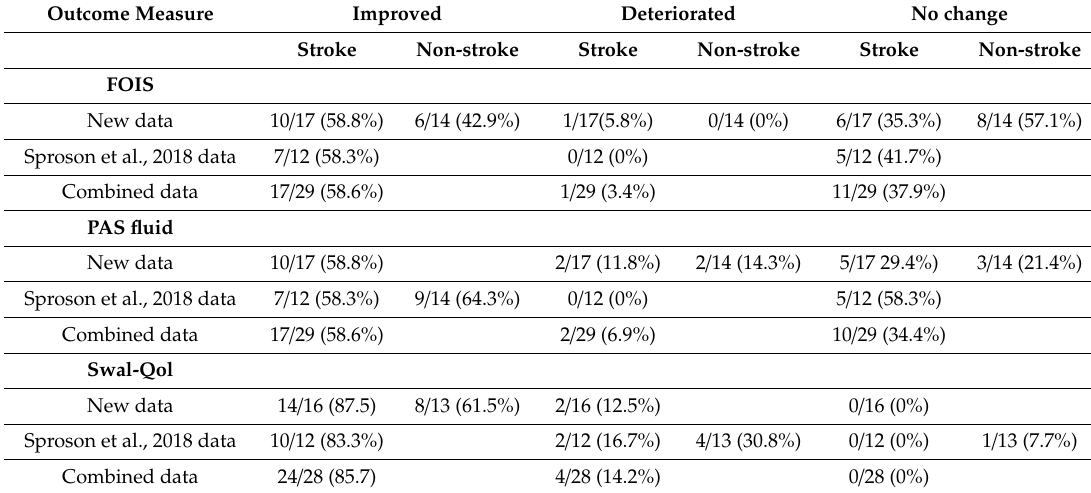
Table 4. Patient outcomes shown separately for the new data set, previously reported data [6], and the combined dataset.